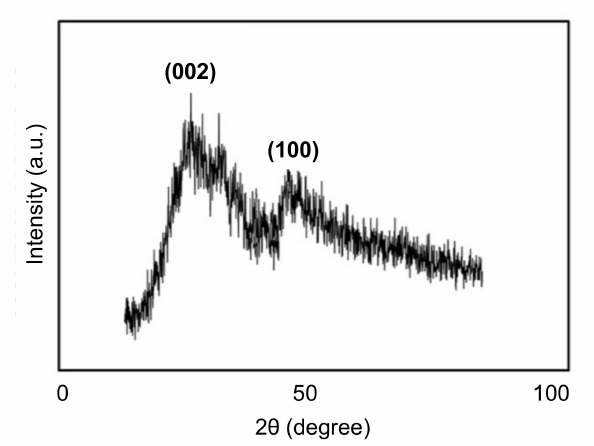
Figure 12. Representation of an XRD pattern for CDs. Reproduced from [173], with permission from Elsevier, 2019. a.u.: arbitrary